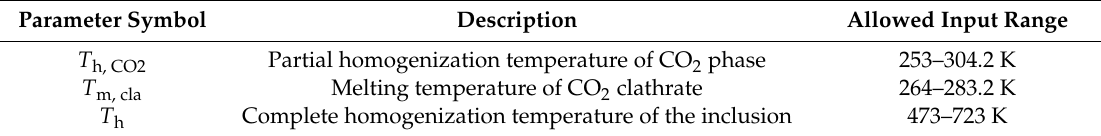
Table 1. Input parameter of the program for H 2 O–NaC–CO 2 inclusion.